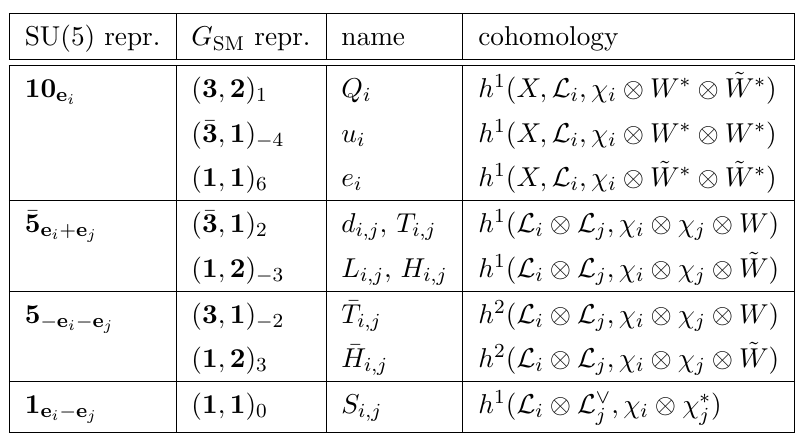
Table 1 . Cohomologies which determine the downstairs spectrum of Line Bundle Standard